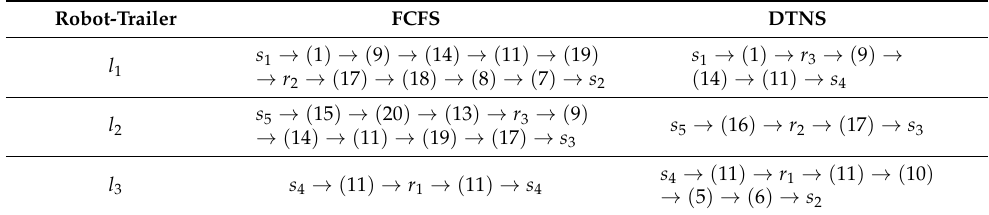
Table 9. Paths obtained by the two algorithms under the condition of three robot-trailer in scenario 1.